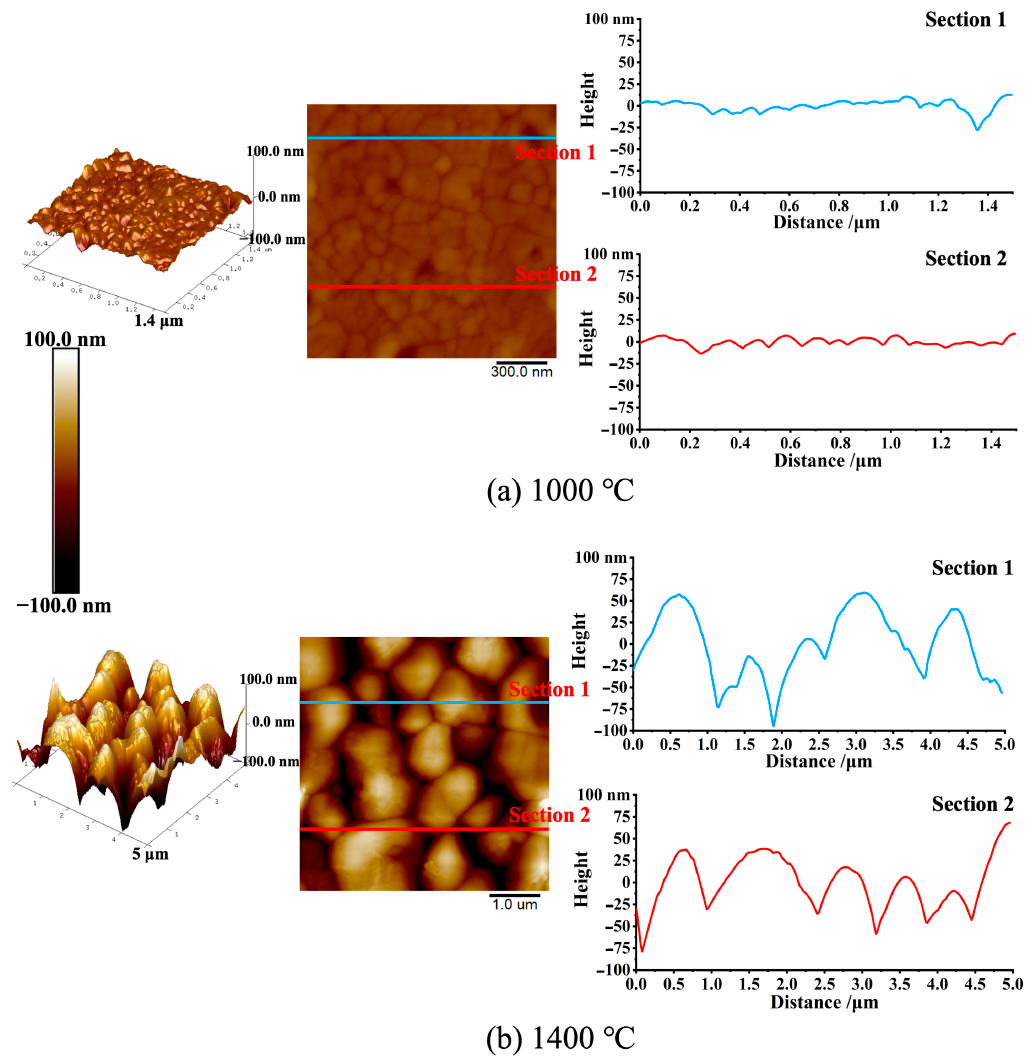
Figure 8. Morphological changes in a splat surface after thermal exposure at ( a ) 1000 °C and ( b ) 1400 °C.